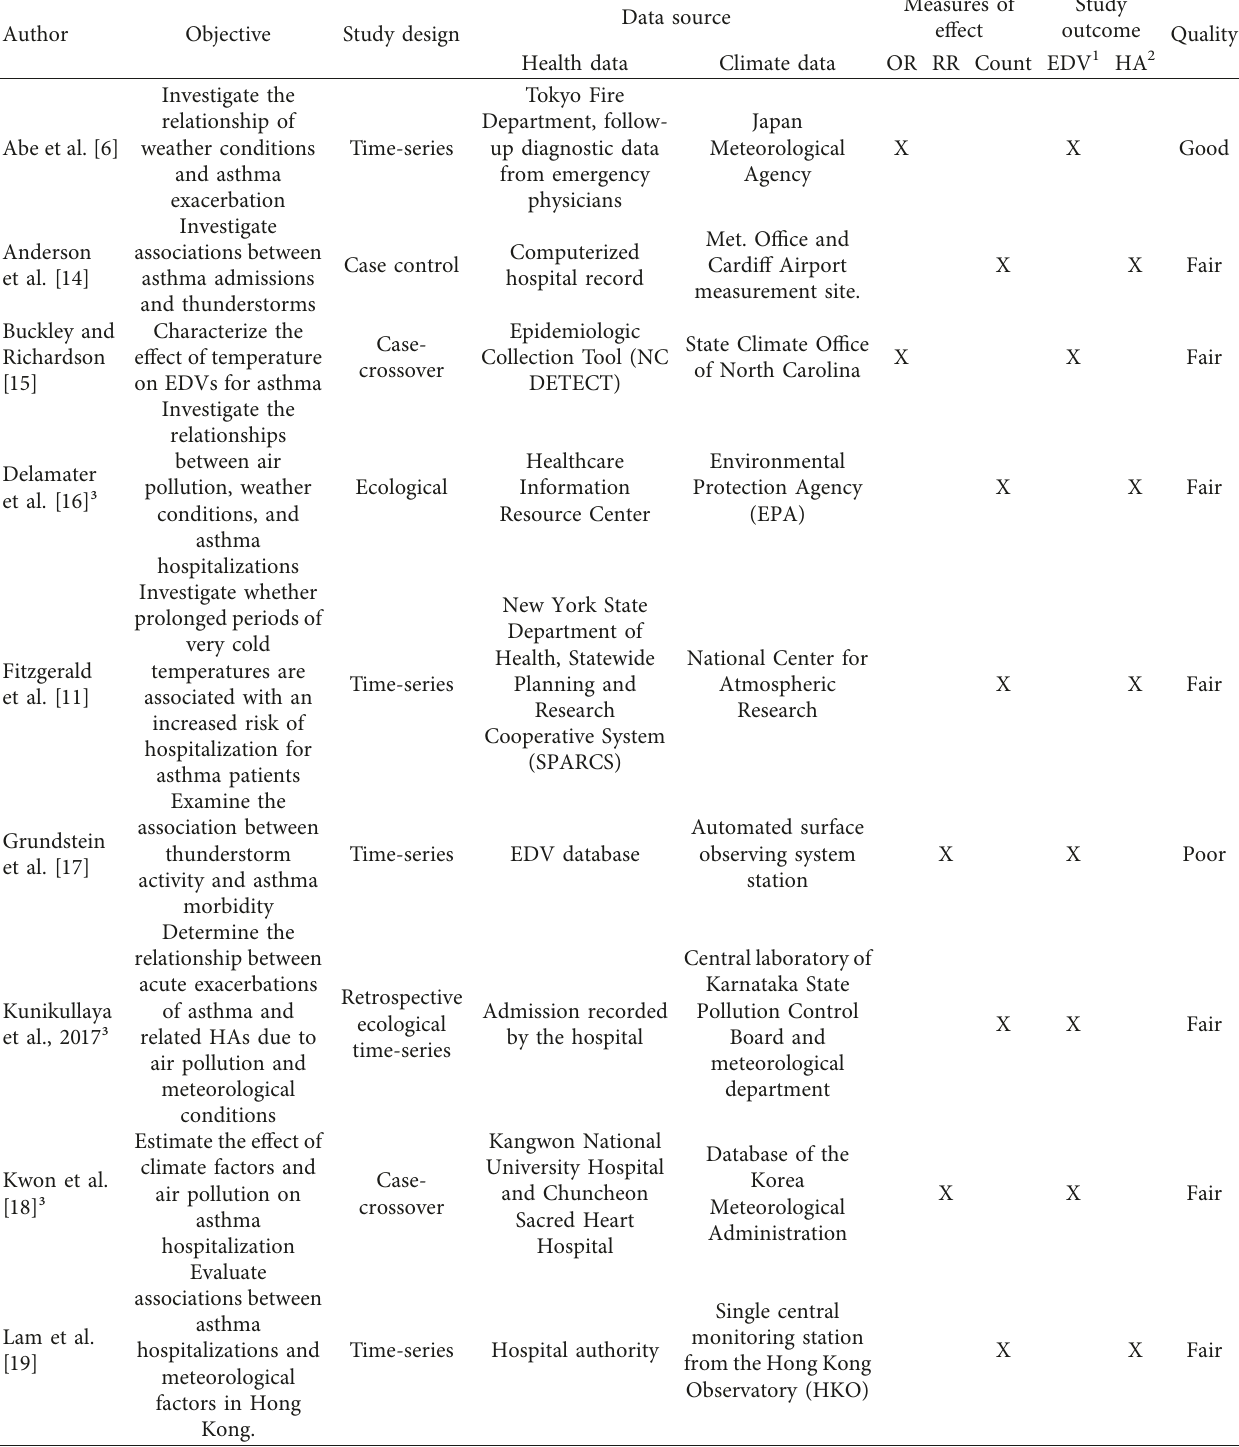
Table 2: Characteristics of studies that examine the effect of meteorological factors on asthma